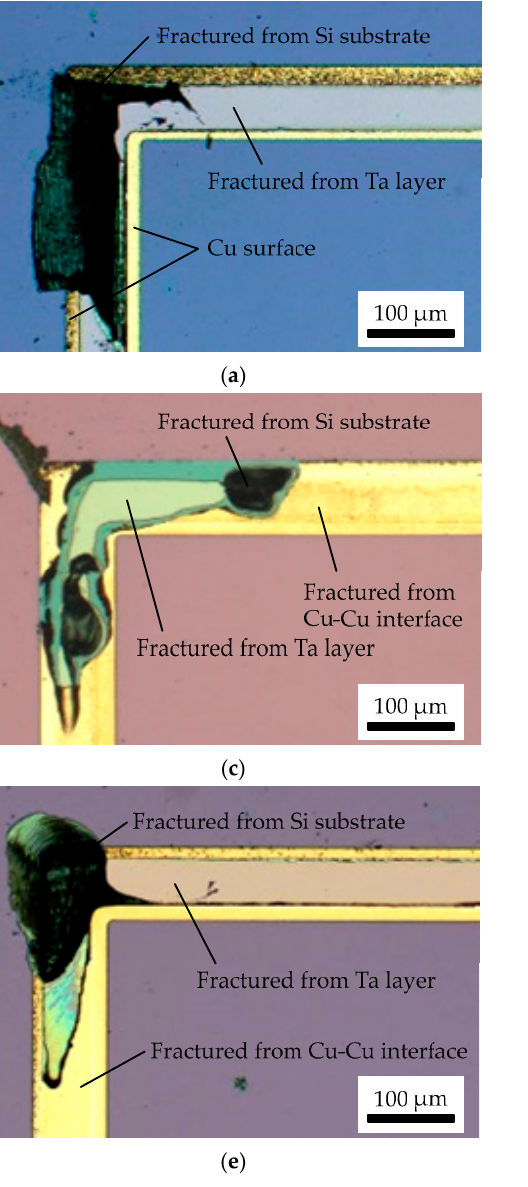
Figure 6. Microscope images on fractured interface of the tensile-tested chips. The chips were bonded at 300 °C. ( a ) Formic acid vapor pre-treated chip; ( b ) H 2 /Ar plasma pre-treated chip; ( c ) NH 3 plasma pre-treated chip; ( d ) hexanethiol SAM pre-treated chip; ( e ) decanethiol SAM pre-treated chip; ( f ) citric acid solution pre-treated chip.